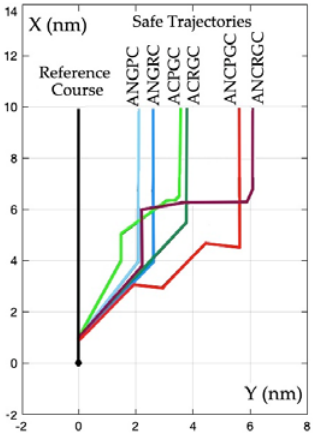
Figure 14. Runs of optimal trajectories for the considered ship in the situation of safely passing 15 ships encountered in the Skagerrak Strait.